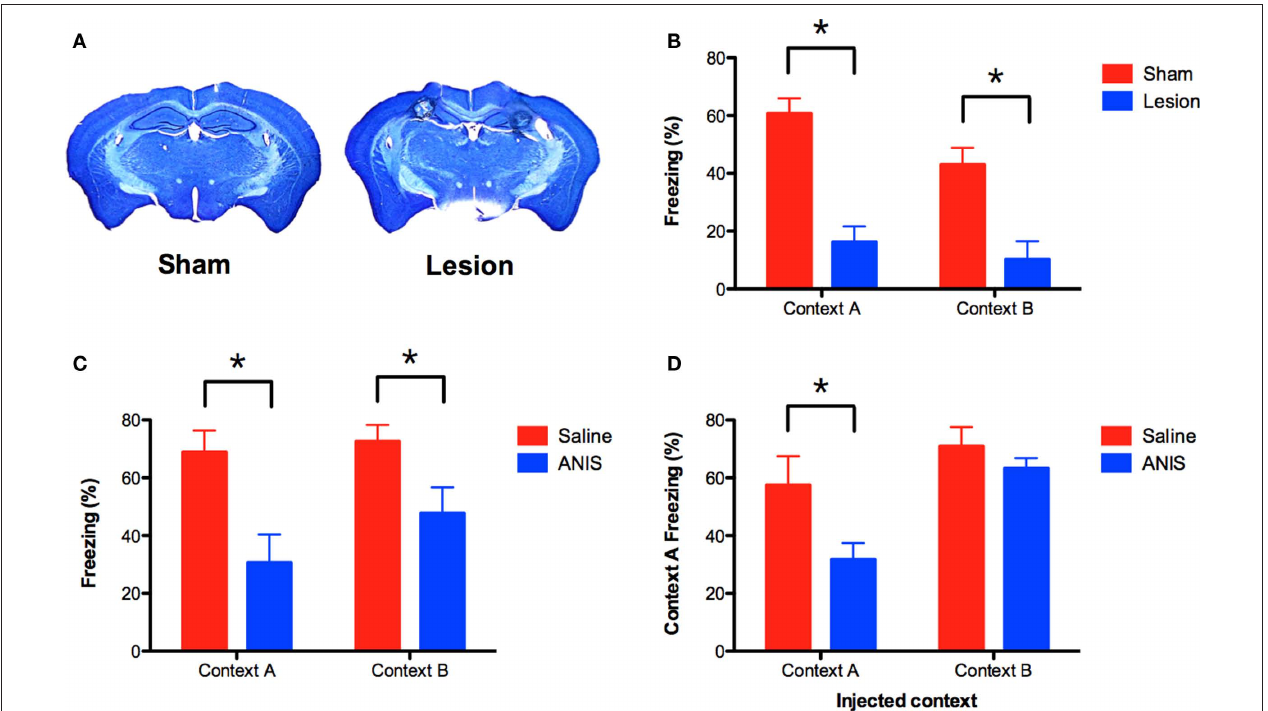
administered IP after training in context A ( n = 8) or context B ( n = 10), and impaired memory in both contexts relative to saline controls ( n = 8, n = 10). (D) Memory for context A was intact in animals that were injected with ANIS after training in context B. Mice that received ANIS in context A continued